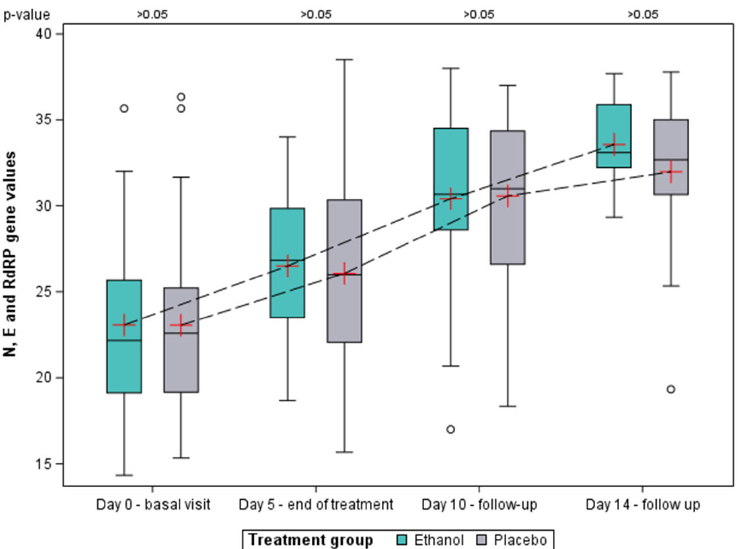
Figure 4. Cycle threshold (Ct) values of the three genes (N, E and RdRP) up to visit on day 14. Mean is represented by a red cross, median is represented by the horizontal line contained in the box, and the first and third quartiles by the lower and upper limits of the box, respectively. The mean Ct values at each visit are linked together by a dashed line for each of the groups.